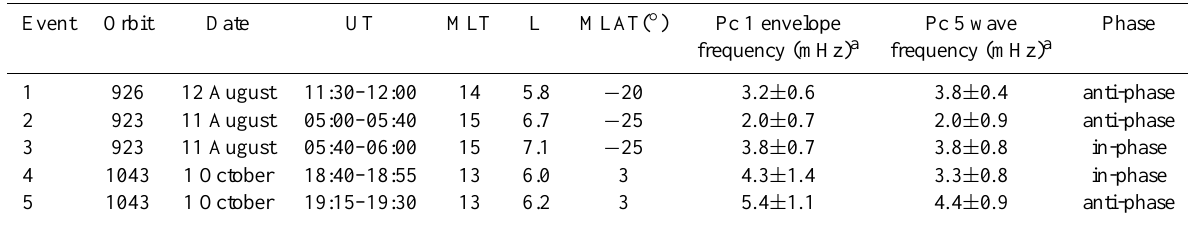
Fig. 4. EMIC waves observed by CRRES during 11 August and 1 October 1991. (a) and (d) transverse magnetic cross powers, (b) and (e) field-aligned Poynting vector spectrograms and (c) and (f) ULF magnetic compressional waves (thickline) and the EMIC wavepacket transverse magnetic envelopes (thinline). The black lines in (a), (b), (d) and (e) represent the local He + ( f He + ) and O + ( f O + ) cyclotron frequencies. Table 1. Example intervals of simultaneous pearl Pc 1 EMIC wave envelopes and Pc 5 wave observations.